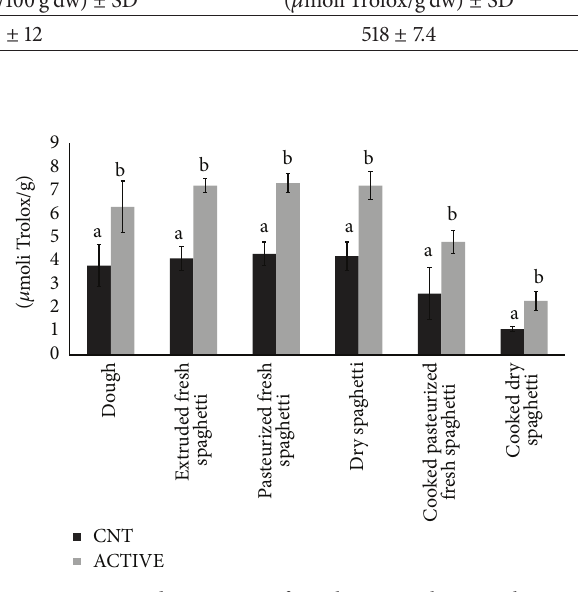
Table 1: Total phenols, total flavonoids, and antioxidant activity of the grape marc extract. Sample